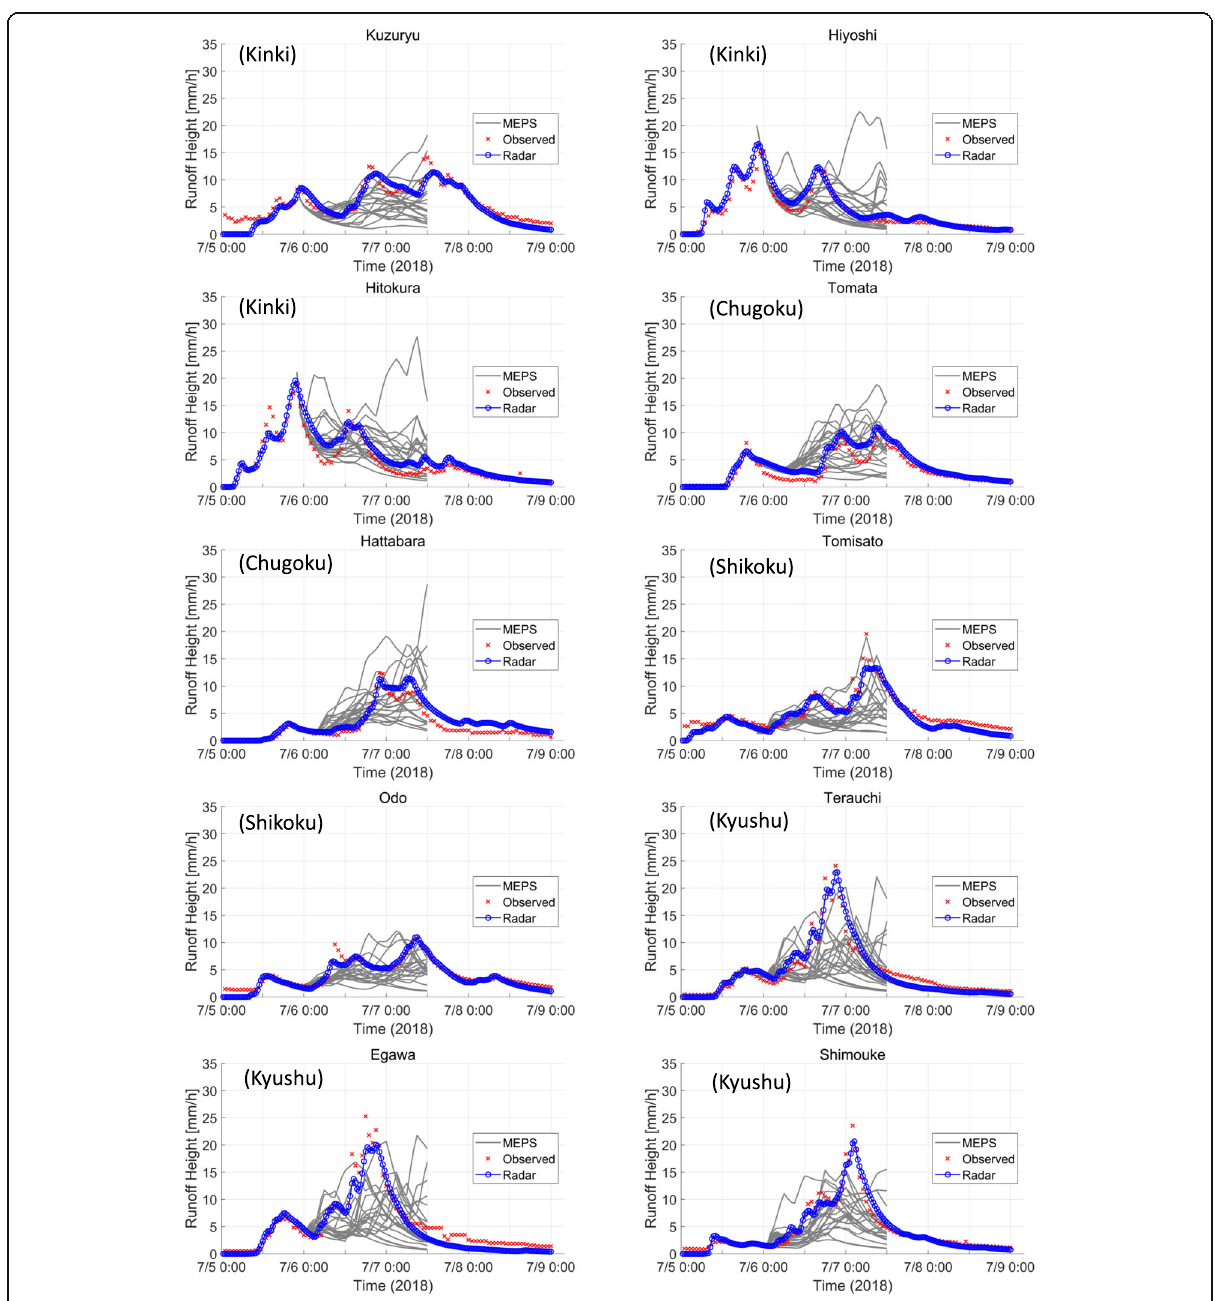
Fig. 1 Observed and simulated hydrographs at dam reservoirs for F18. The “ radar ” shows the simulated hydrographs, and “ MEPS ” shows the forecasted results initialized at 21:00 on 5 July 2018, by 21 ensemble members. Names in the parentheses show the regions to which each dam